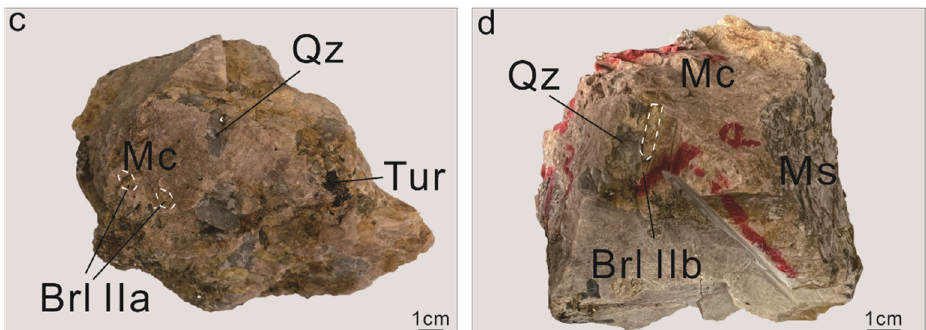
Figure 5. Hand specimen photographs of representative samples from different zones of the Dakalasu No.1 pegmatite. ( a ) Typically, the wall zone of granitic pegmatite, which is an intergrowth of Tur + Qz + Brl; ( b – d ) Prismatic beryl from the intermediate zone, and is associated with Qz + Mc ± Ms. Abbreviations: Brl = beryl, Qz = quartz, Mc = microcline, Ms =muscovite and Tur = tourmaline.